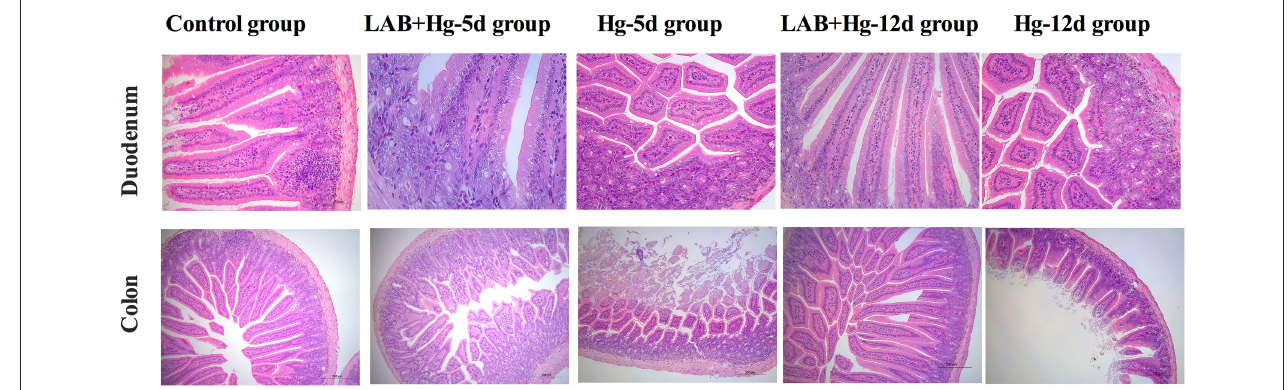
FIGURE 2 | Microscopic examination revealed obvious differences in the five groups in small intestine samples from duodenum and colon. Histopathological examination of H&E-stained small intestinal tissues were analyzed in control, LAB + Hg-5d, Hg-5d, LAB + Hg-12d and Hg-12d groups. The top pictures illustrate pathological changes in the jejunum, and the scale bar is 100 µ m. The bottom pictures show pathological changes in the ileum, and the scale bar is 200 µ m. Histological pictures are representative of sections derived from each group.